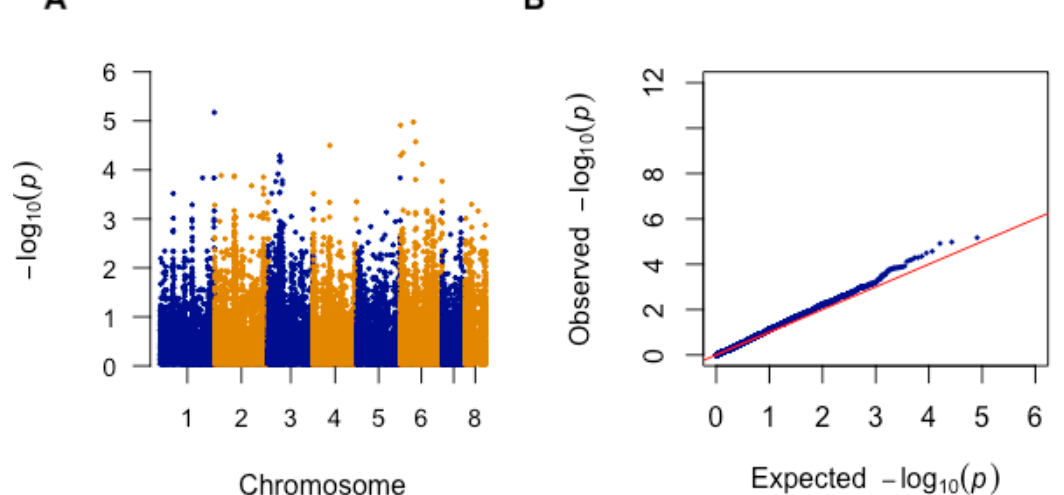
Figure 4. ( A ) The Manhattan plot for AMB sensitivity of A. fumigatus isolates in Cluster 2 ( n = 33). The plot is based on − log 10 ( p -value) and chromosome position. ( B ) Quantile–quantile (Q–Q) plot from genome-wide association (GWA) analysis of AMB sensitivity. Comparison of observed − log 10 ( p -value) to the expected − log 10 ( p -value). Table 6. Top 15 significant SNPs associated with AMB resistance based on a genome-wide association study